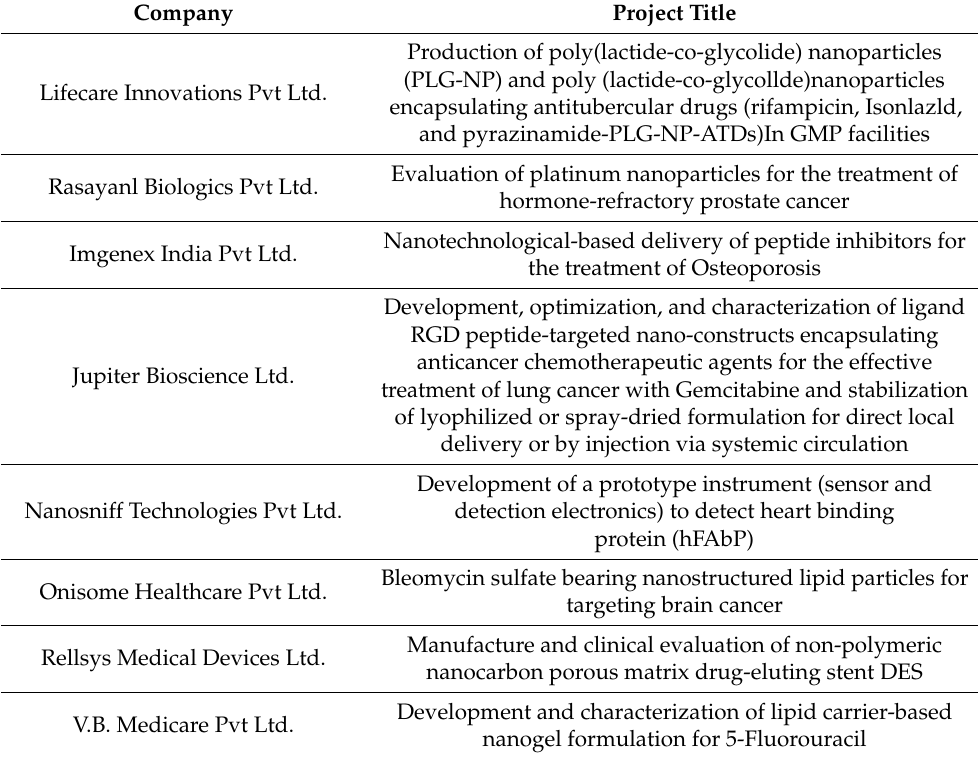
Table 3. Research projects sponsored by BIRAC under industrial and academic collaboration